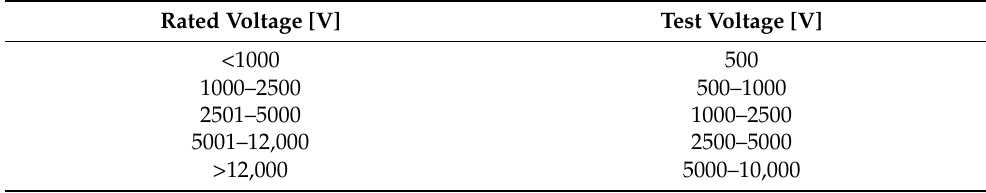
Table 1. Values of test voltages during the measurement IR.